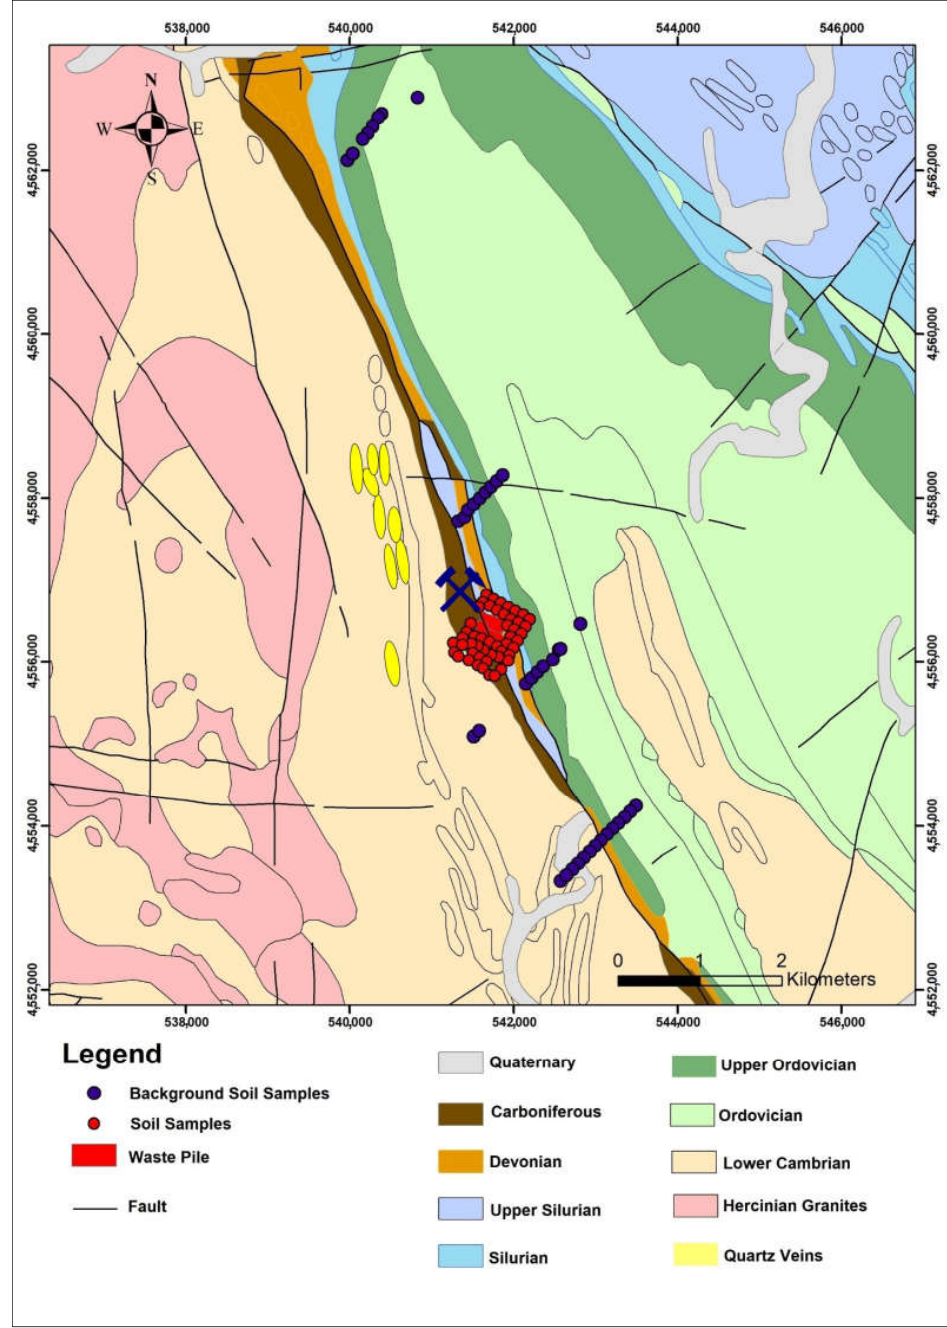
Figure 2. General geologic setting of the studied area with location of soil samples surrounding the waste pile and the samples used to infer the regional geochemical background. Geology adapted from the geological map of Portugal, at scale 1:200,000 [58].